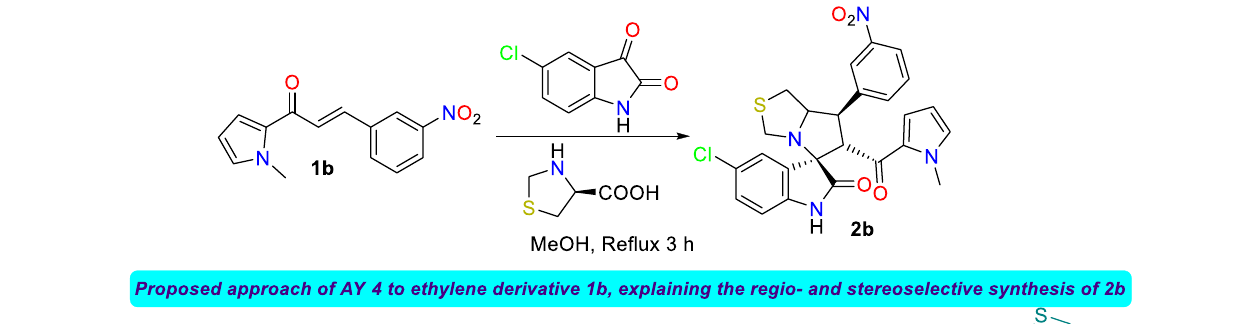
SCHEME 3 | Synthesis and plausible mechanism for the desired spirooxindole derivative 2b